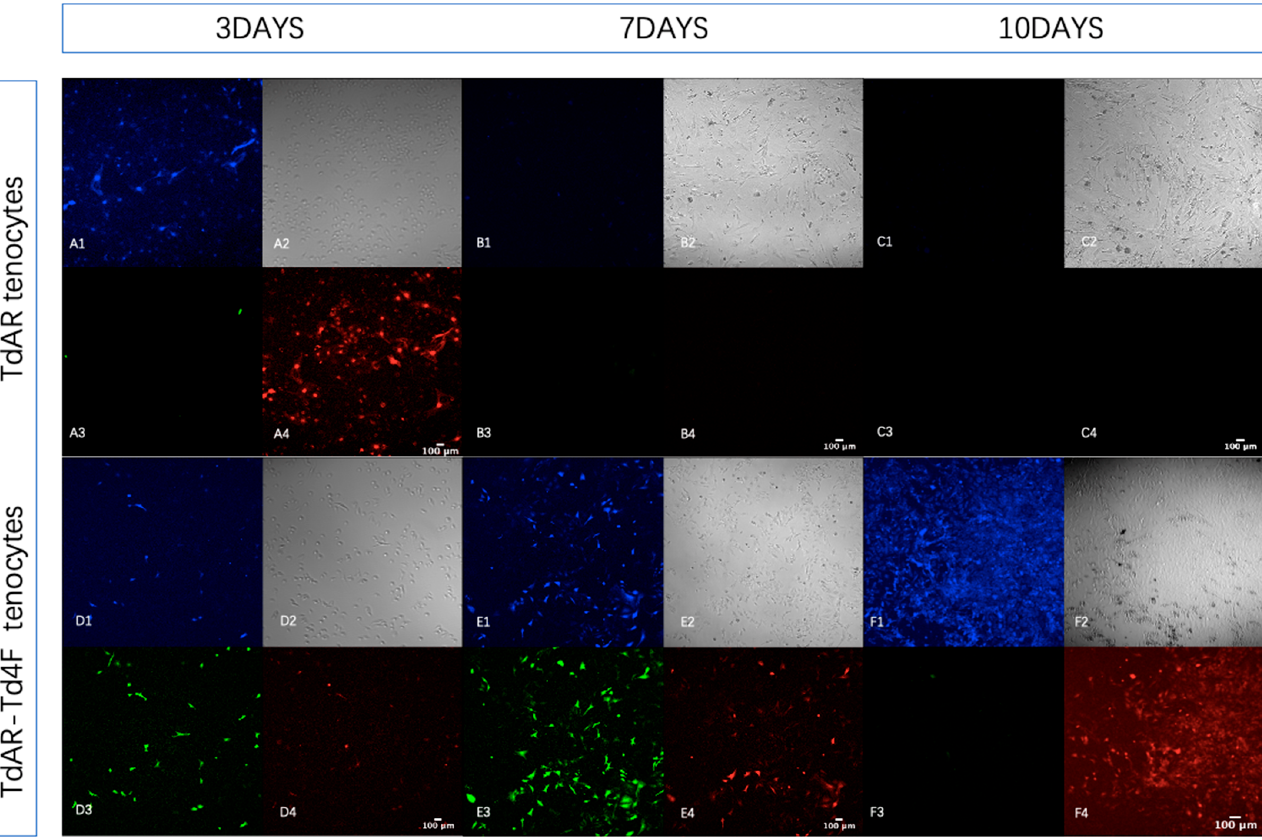
Figure 5. Td4F increased Scx-mScarlet and Col1a1-BFP expression in Scx+ primary Achilles tendon cells in vitro. To confirm, at the cellular level, the increased expression of Scx-mScarlet and Col1a1- BFP in Scx+ primary Achilles tendon cells after induction of Td4F-EmGFP overexpression, tendon cells were extracted from the Achilles tendons of TdAR mice and TdAR-Td4F mice, respectively, for 24 h of induction. The experiment was repeated three times independently, using cells from different donors. ( A – C ) show primary Achilles tenocytes from TdAR mice cultured under confocal microscopy for three, seven and ten days ( × 10 magnification); 1 – 4 show Col1a1-BFP ( A1 – F1 ), brightfield ( A2 – F2 ), Td4F-EmGFP ( A3 – F3 ) and Scx-mScarlet ( A4 – F4 ) ( × 10 magnification) in confocal microscope view. It can be seen that in the absence of overexpression of Td4F, Scx-mScarlet and Col1a1-BFP gradually decreased. At ten days, the signal was almost completely unobservable, implying that these genes lost expression. ( D – F ) show views of tendon cells from TdAR-Td4F mice cultured for three, seven and ten days, respectively, under confocal microscopy ( × 10 magnification). ( D ) One day after exposure to doxycycline culture, EmGFP expression began in tendon cells from TdAR-Td4F mice, indicating that Td4F was significantly overexpressed in Scx+ cells from TdAR-Td4F mice. ( E ) Td4F overexpression resulted in enhanced expression of Scx-mScarlet and Col1a1-BFP compared to three days. ( F ) Expression of Col1a1-BFP and Scx-mScarlet remained at high levels after Td4F-EmGFP expression was